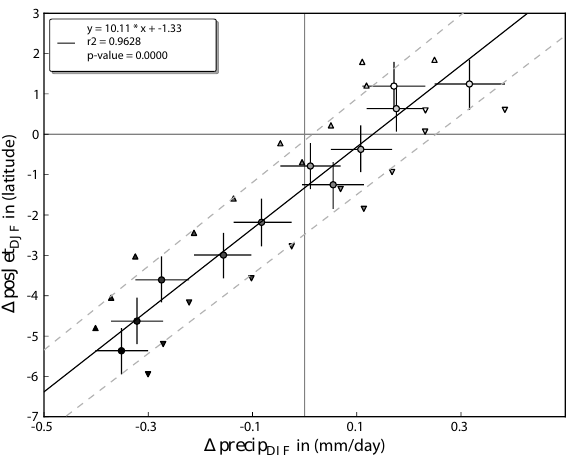
Figure 10. 850hPa winter jet-stream shift (in latitude) vs. winter precipitation anomaly over the Scandinavian region. The range of results has been obtained by bootstrapping. Up and down trian- gles represent the 5th precipitation percentile vs. the 95th jet po- sition percentile, and the 95th precipitation percentile vs. the 5th jet position percentile respectively. Circles are the average values and crosses indicate the 5th and 95th percentiles.